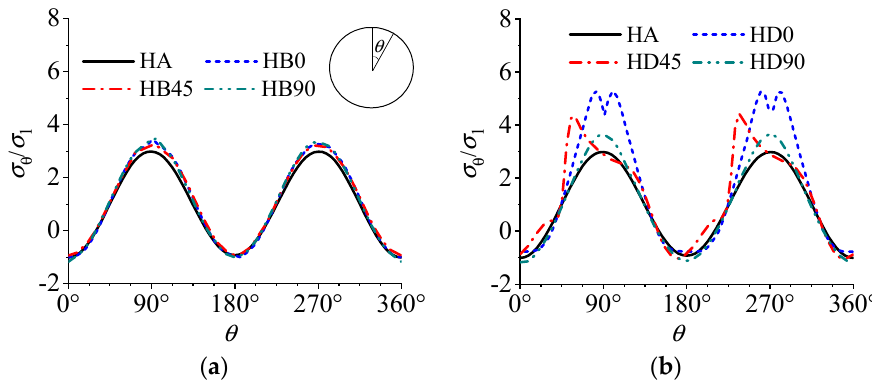
Figure 24. σ θ / σ 1 along the hole periphery at σ 1 = 1 MPa in the specimens with k = 0.2 and 0.8 at β = 0°, 45° and 90°. ( a ) k = 0.2; ( b ) k = 0.8.